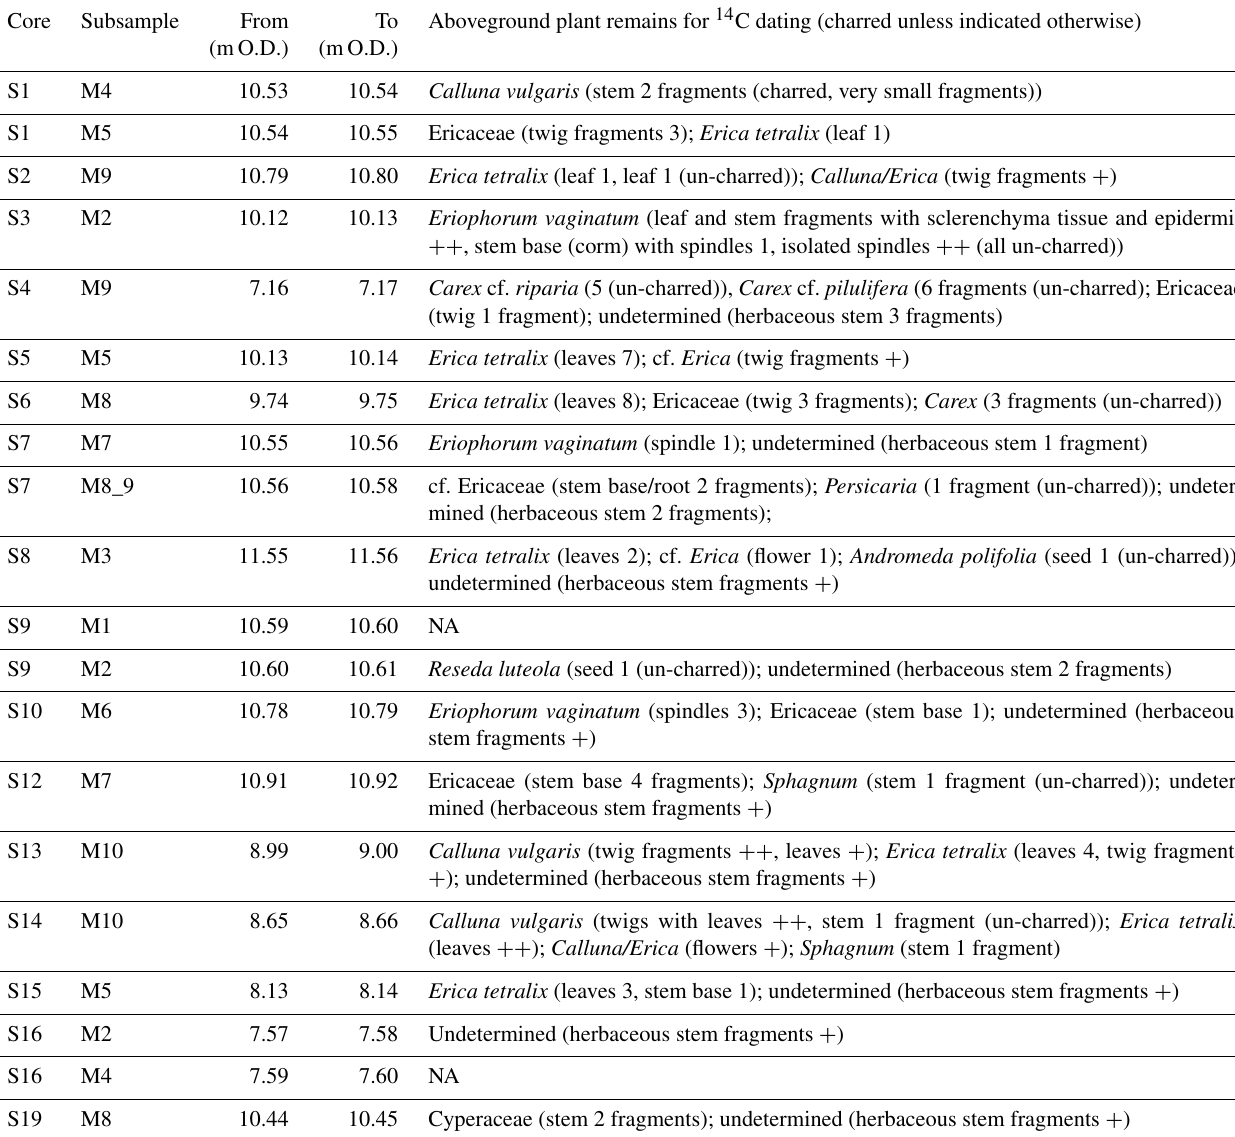
Table 1. Overview of the aboveground plant remains that were selected for radiocarbon dating. When a number is given, this is the exact amount encountered; cf. = resembles, += present, ++= frequent, and NA = not